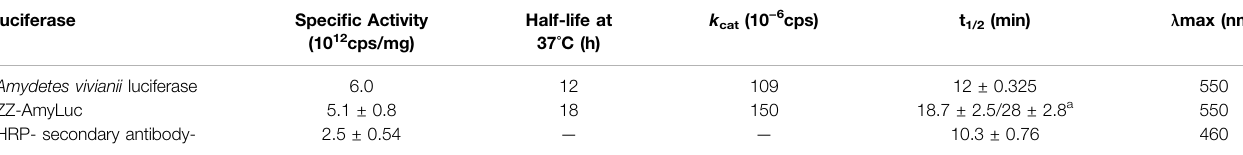
TABLE 1 | Luminescence properties of ZZ-AmyLuc fusion protein, wild-type Amydetes vivianii luciferase and HRP-conjugated secondary antibody from GE Healthcare.